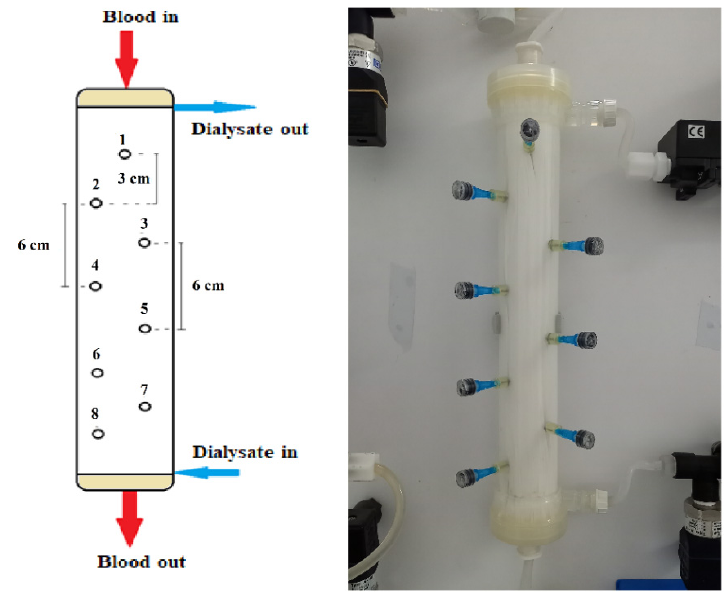
Figure 2. Schematic and image of the instrumented haemodialyzer, showing geometrical details of the eight (#1 to #8) sampling ports/locations. Blood- and dialysate-side feed-fluids pumped at the top and bottom, respectively.